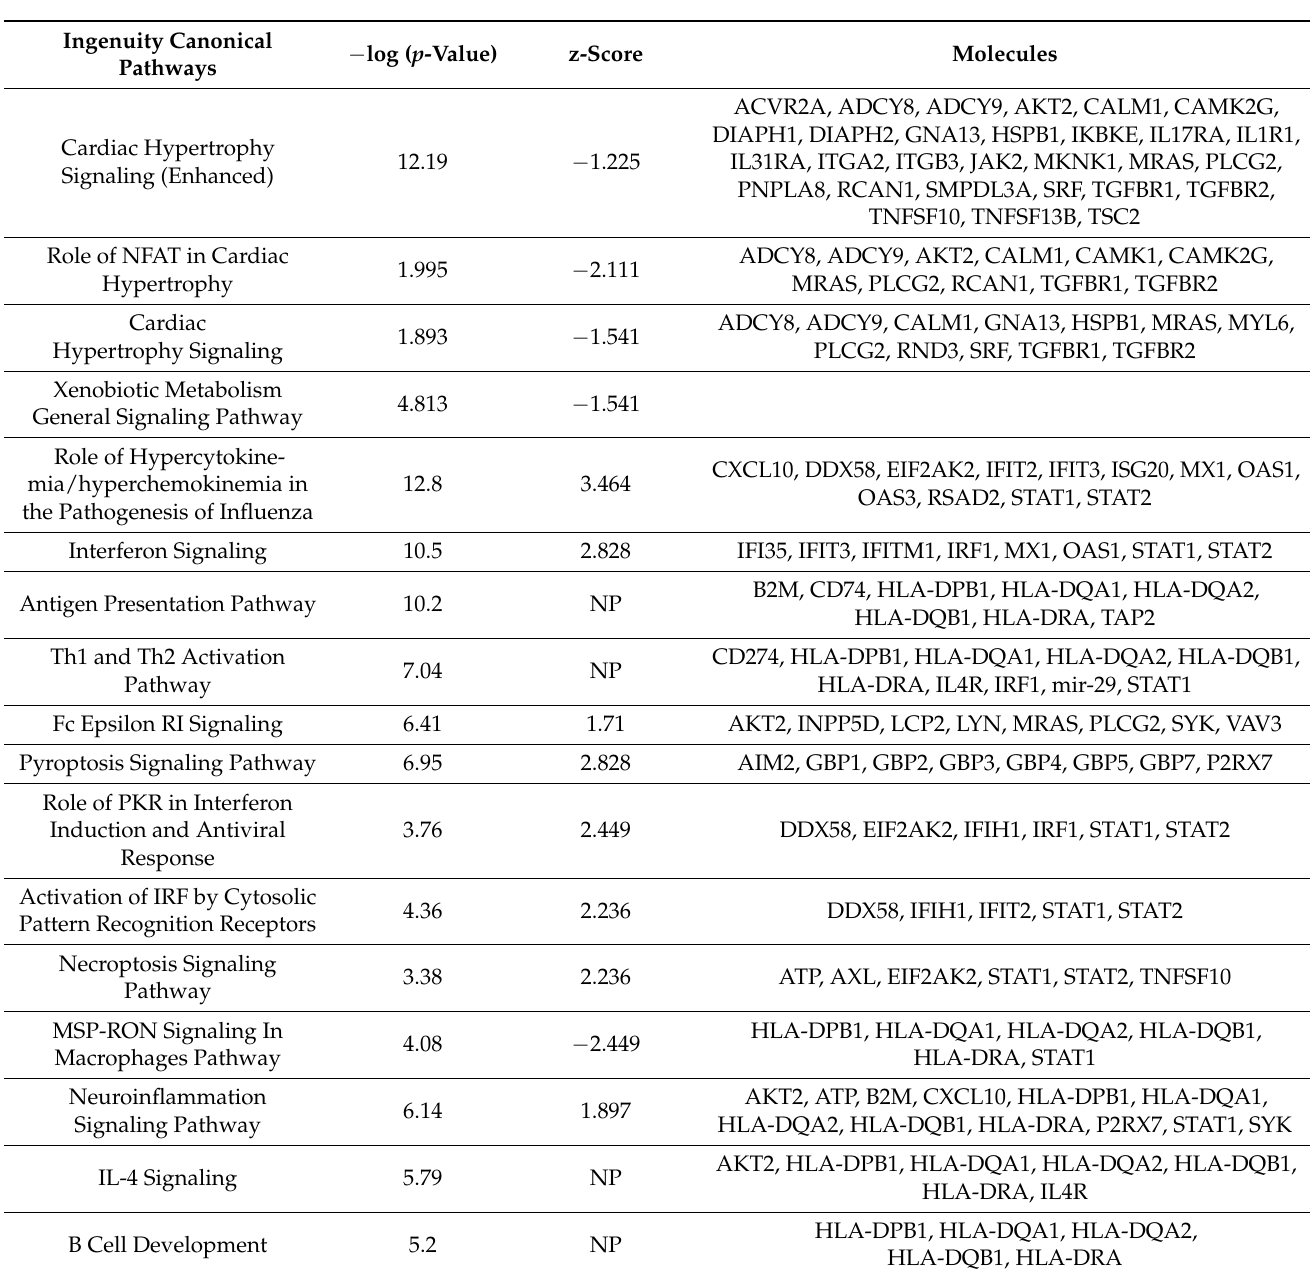
Table 3. Most associated, activated, and inhibited canonical pathways canonical pathways identified in the “IFN- γ + kaempferol” treatment